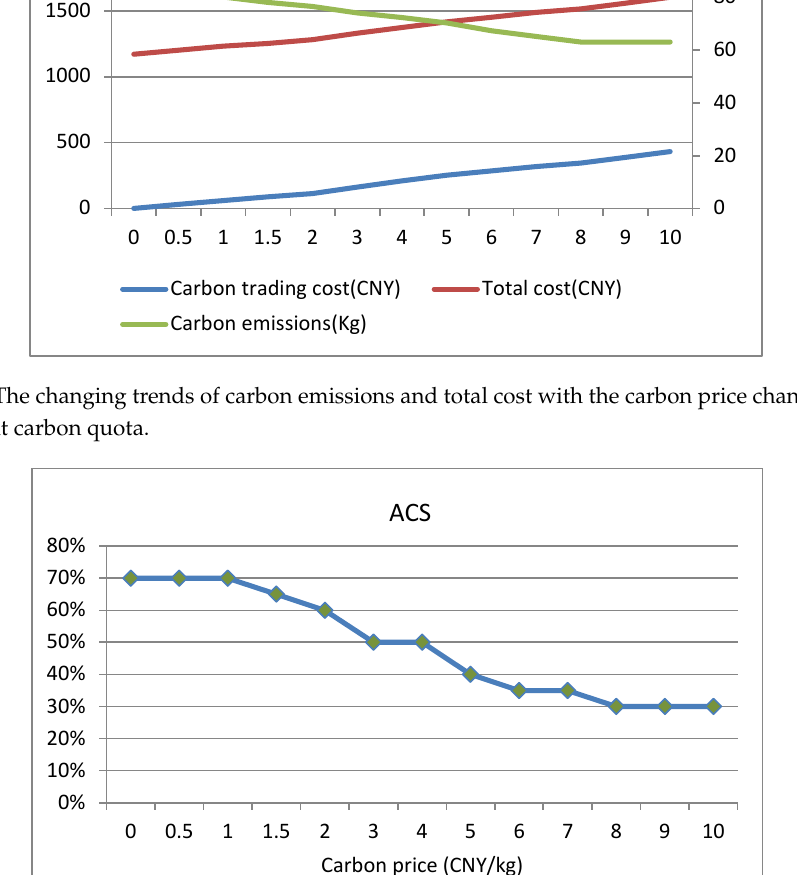
Figure 6. The changing trends of carbon emissions and total cost with the carbon price changes under sufficient carbon quota.